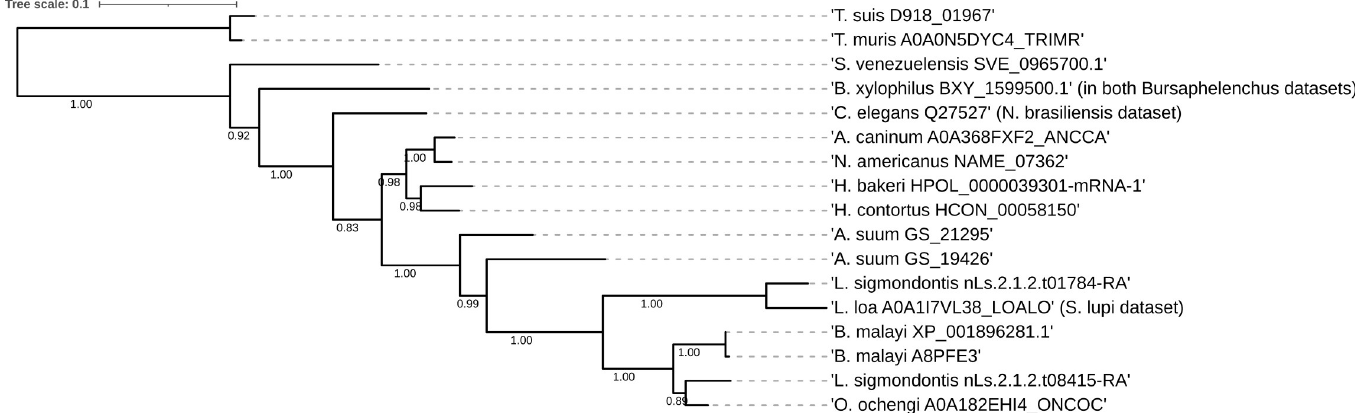
Fig 2. Maximum likelihood phylogeny of enolase protein sequences. Scale bar represents distance. Numbers indicate the SH-like support for each node. The tree is rooted at the divergence of clade I nematodes. The tree follows the expected divergence based on species. The dataset of origin is indicated in brackets, in case a homologous species name was used as description in the original reports. The placement of C . elegans Q27527 (sequence from the N . brasiliensis dataset) outside clade V does not have reliable support in the data (bootstrap = 0.83). D . immitis and S . ratti also showed enolase sequences, which are not depicted in this graph due to sequence selection described in the methods